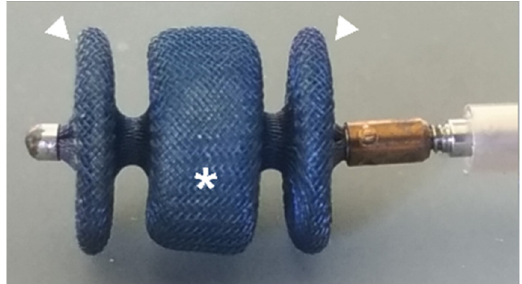
Figure 1. Amplatzer vascular plug II with two lateral retention discs (arrowhead) and central component (asterisk): self-expanding device made from a nitinol wire mesh. The device is attached by a microscrew to a 135 cm nitinol delivery wire in a hoop dispenser and preloaded in a loader. Premedication included methadone (0.2 mg/kg, intramuscularly [IM]).